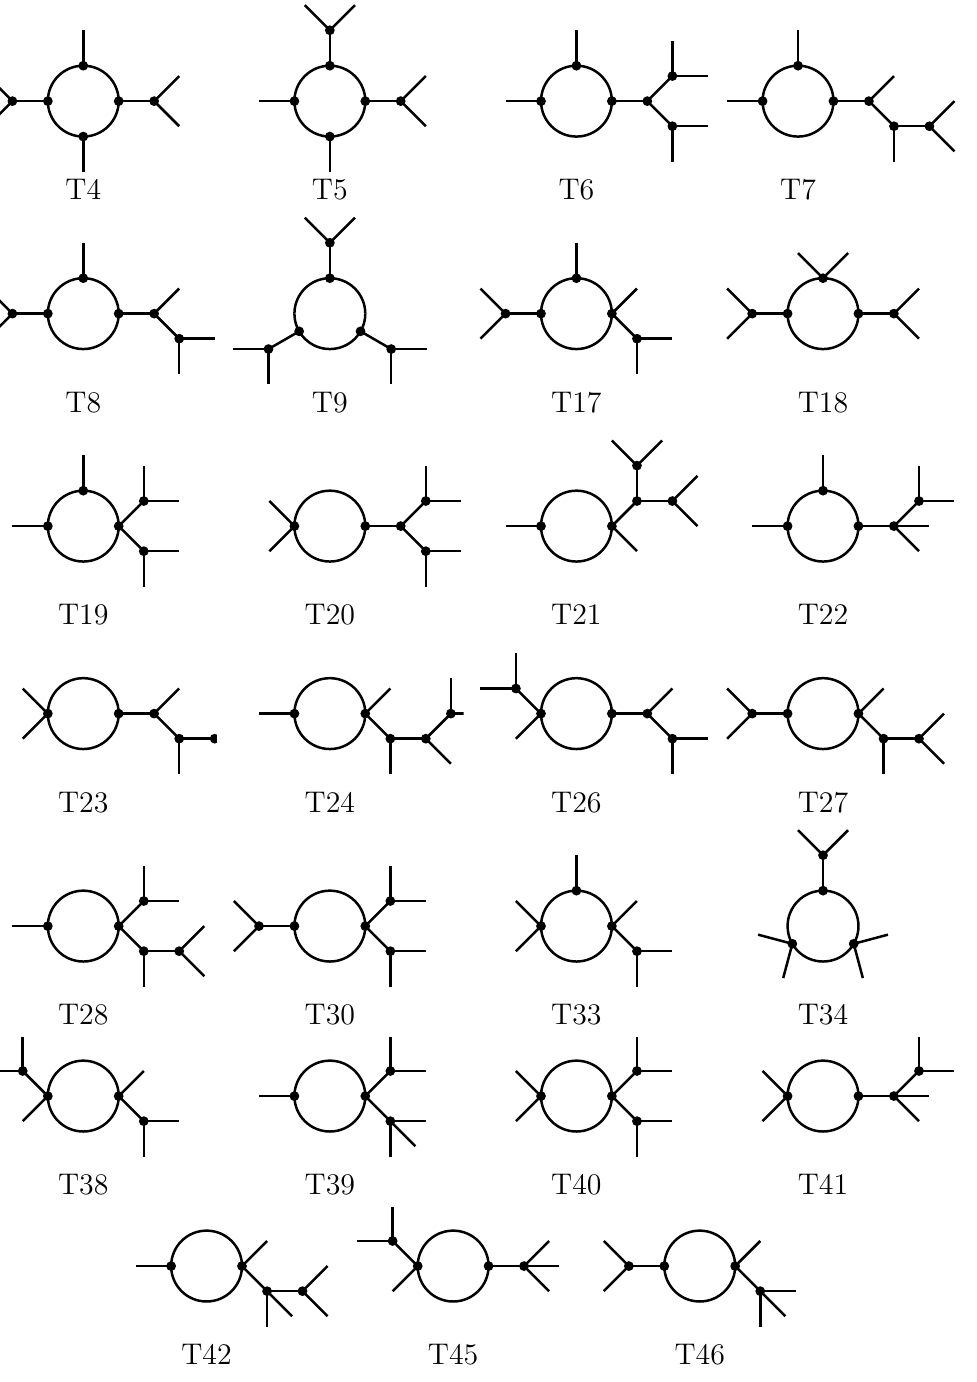
Figure 14 . Topologies that necessarily lead to a d = 5 tree level neutrino mass, see text.